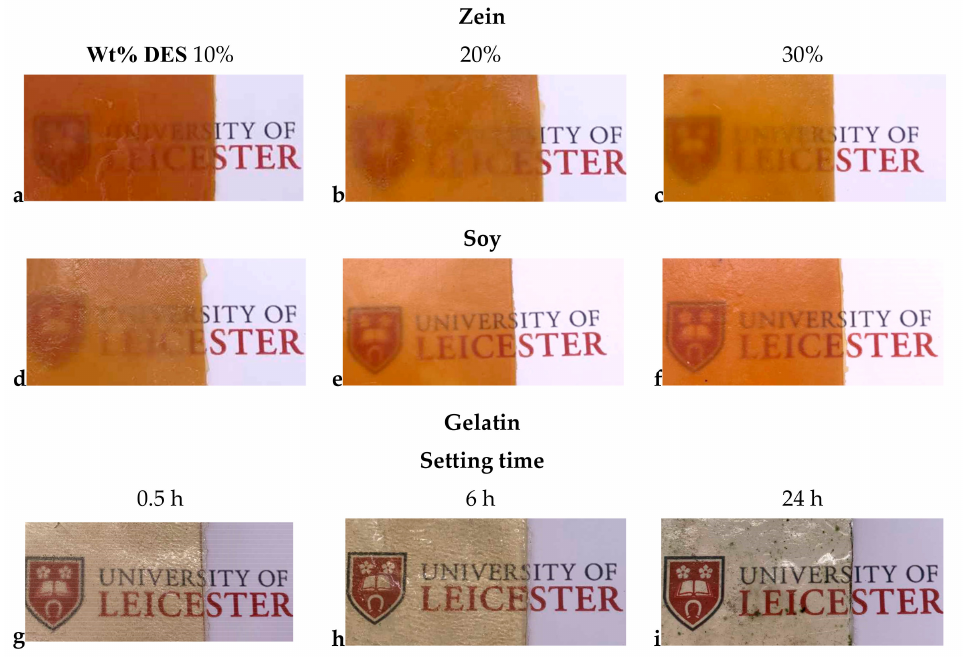
Figure 1. Photographs of zein ( a – c ) and soy ( d – f ) proteins with di ff erent DES contents and for gelatin samples with 20% DES after setting time of ( g ) 0.5, ( h ) 6 h, and ( i ) 24 h